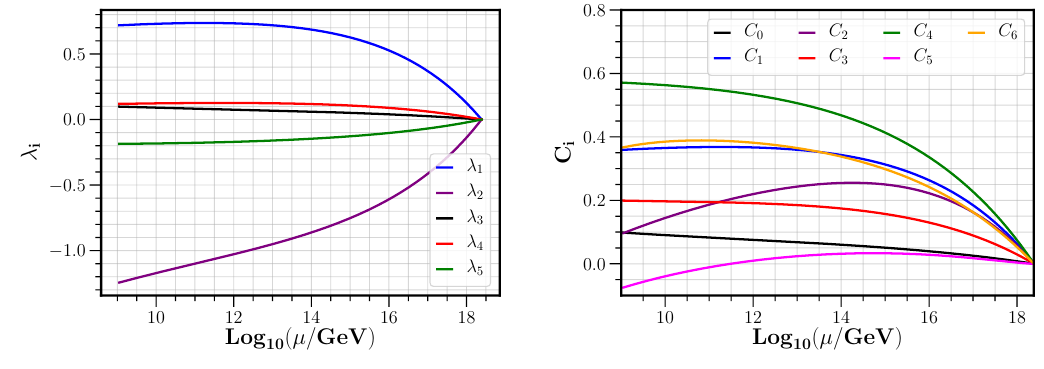
Figure 6 . Running of the triplet quartic couplings (left figure) and the conditions for the classical stability of the potential (right figure) for M ∆ = 10 9 GeV and Y ∆ = 1 . 3 considering right-handed neutrinos with Y Φ = 0 . 37 . Left: all quartic couplings vanish at the Planck scale. Also, note how λ 1 and λ 2 have opposite trends. The same occurs for λ 4 and λ 5 . This is due to the difference the sign contribution of the gauge and neutrino Yukawa couplings in eq. (3.8)–(3.11). Right: see how the Yukawa interaction of the neutrinos with the Higgs, Y Φ , stabilises the joint doublet-triplet potential with C 1 , C 2 , C 3 , C 4 , C 6 > 0 in all the range of scales. Note that C 5 is not positive throughout all the